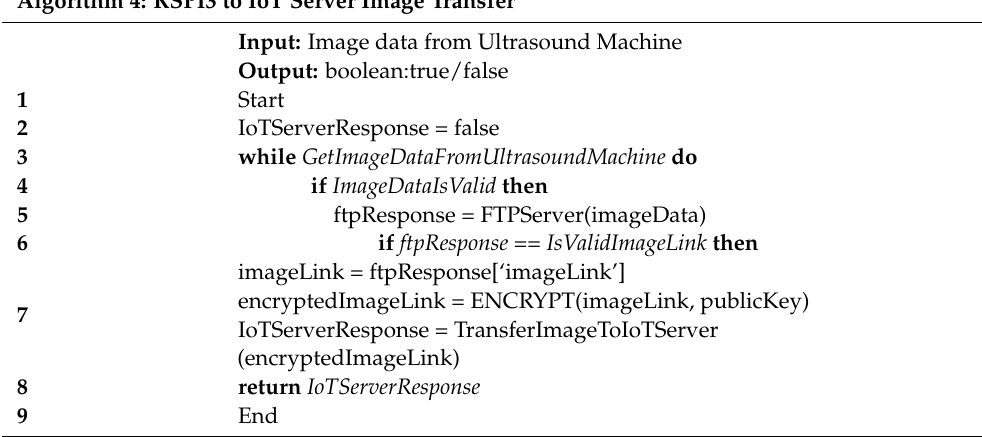
Algorithm 4: RSPI3 to IoT Server Image